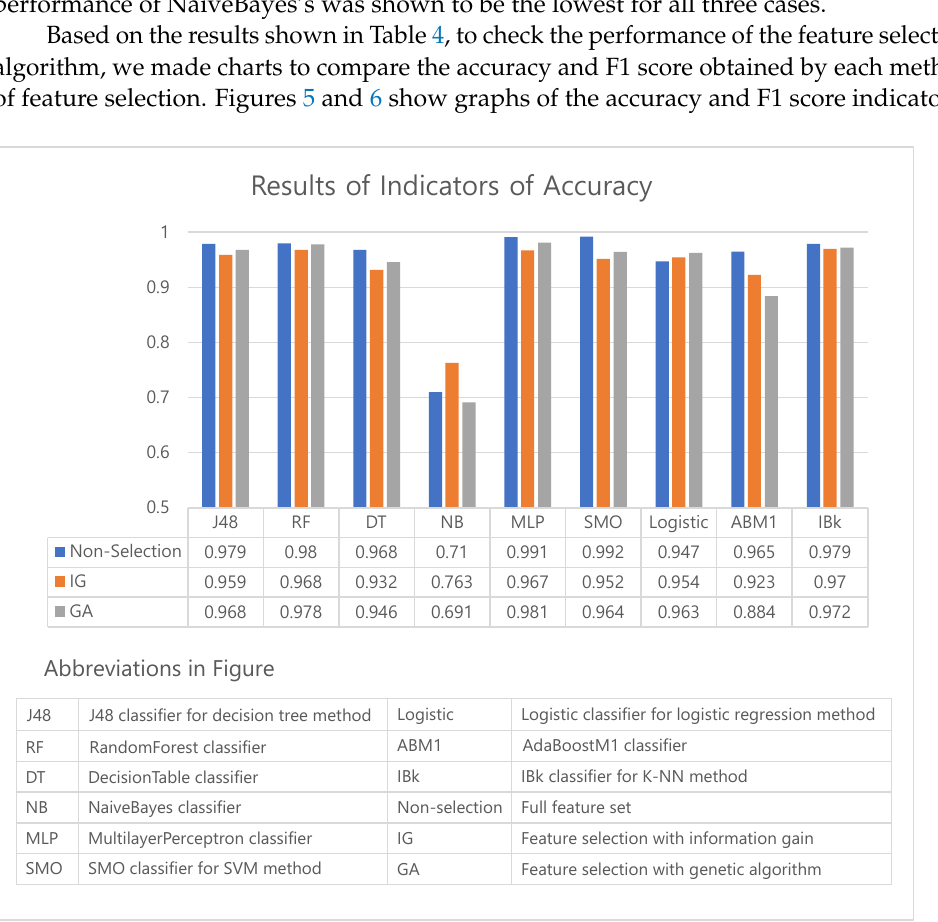
Figure 5. A graph comparing accuracy among feature selection